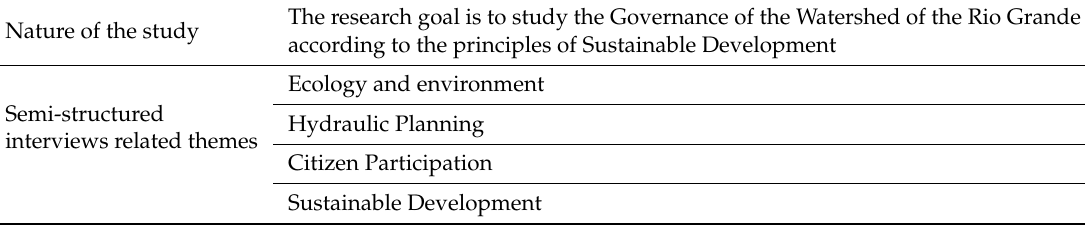
Table A3. Semi-structured interviews. The above list of topics is only indicative.